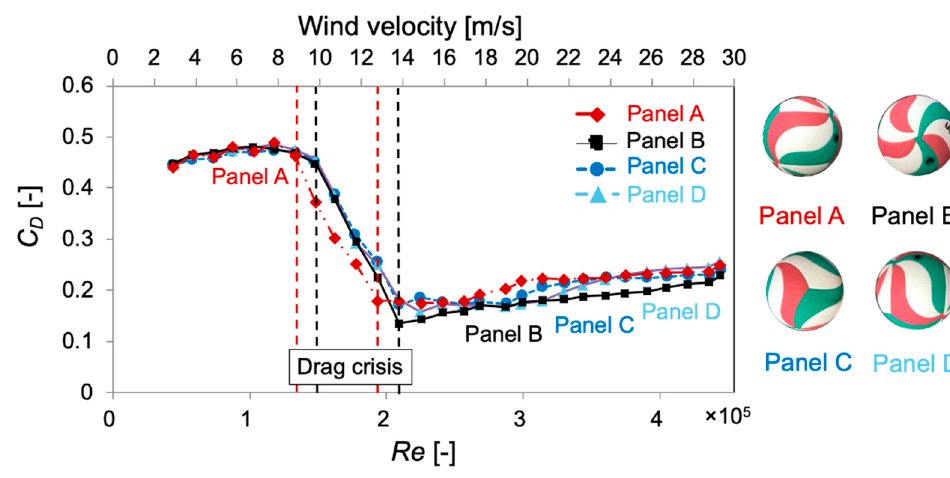
Figure 7. Relationship between Reynolds number and drag coefficient on FLISTATEC . Appl. Sci. 2021 , 11 , 9269